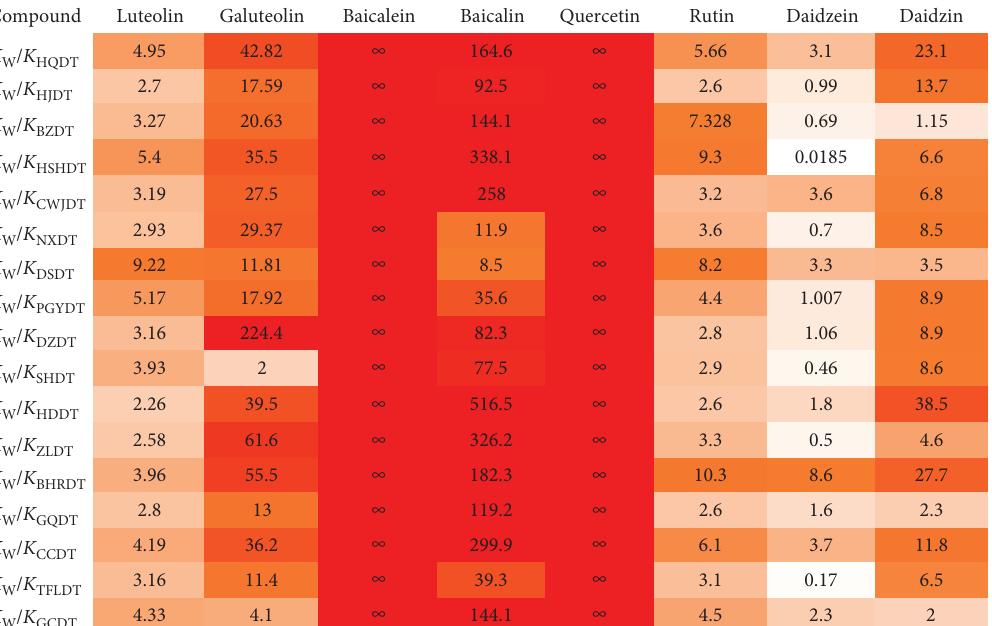
Figure 4: Heat map showing the effect of polysaccharides on the stability of flavonoids. The ratio of the degradation rate constants in water to polysaccharide solution is shown.